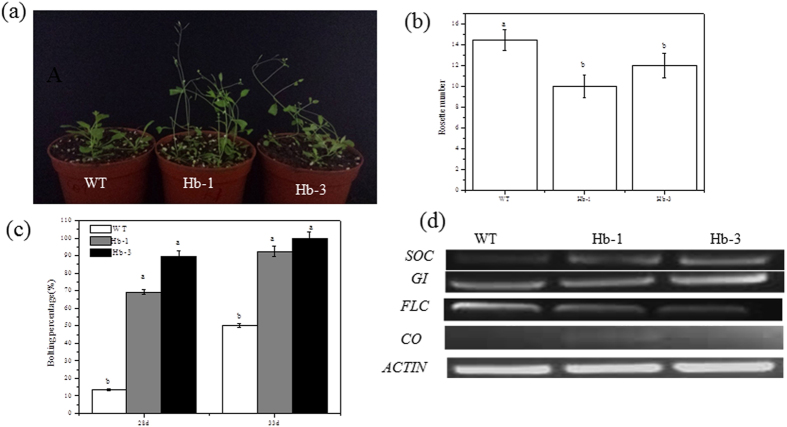
Overexpression SoHb transgenic plants showed earlier flower time phenotype.(a) SoHb transgenic lines flowered earlier. WT and SoHb transgenic lines were grown in soil under 16 h light/8 h dark cycles and were photographed after 28 d of growth. (b) Rosette leaf number of WT and transgenic SoHb lines during flowering (n > 30 plants). (c) The percentage of flower plants of WT and transgenic SoHb lines (n > 30 plants). (d) SOC, FLC, CO and GI expression in WT and transgenic SoHb lines assayed by semi-quantitative RT-PCR. All experiments were repeated at least three times. Means denoted by different letters show significant differences at P < 0.05 according to Duncan test.